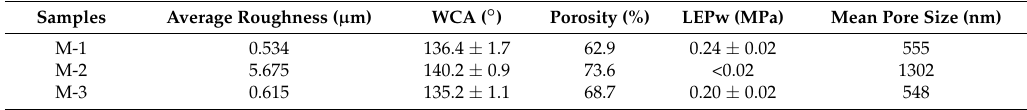
Table 2. The properties of the sintered PTFE hollow fiber